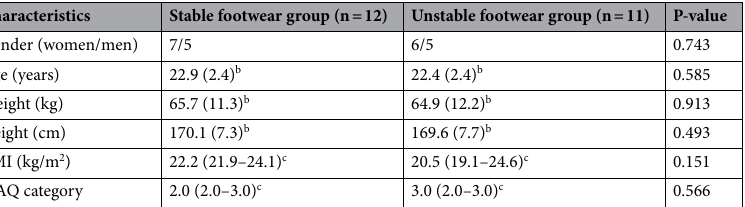
Table 1. Participant characteristics at baseline a . The data shown are the mean (standard deviation ( SD )) or median (interquartile range (IQR)). BMI = body mass index; IPAQ = International Physical Activity Questionnaire. a No group differences were observed. b Mean (standard deviation ( SD )). c Median (interquartile